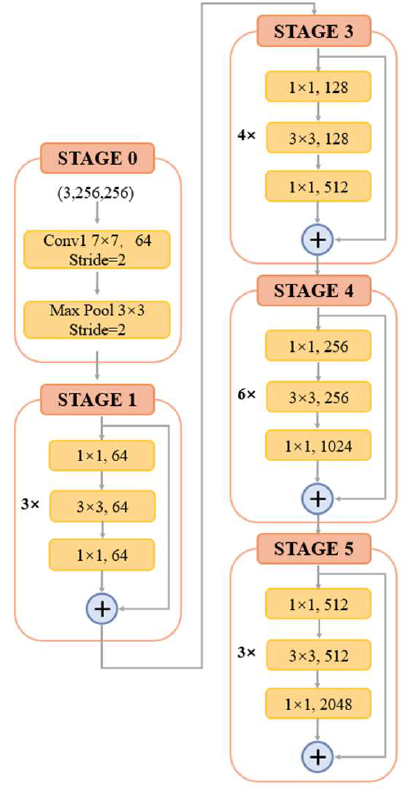
Figure 3. The structure of ResNet-50.